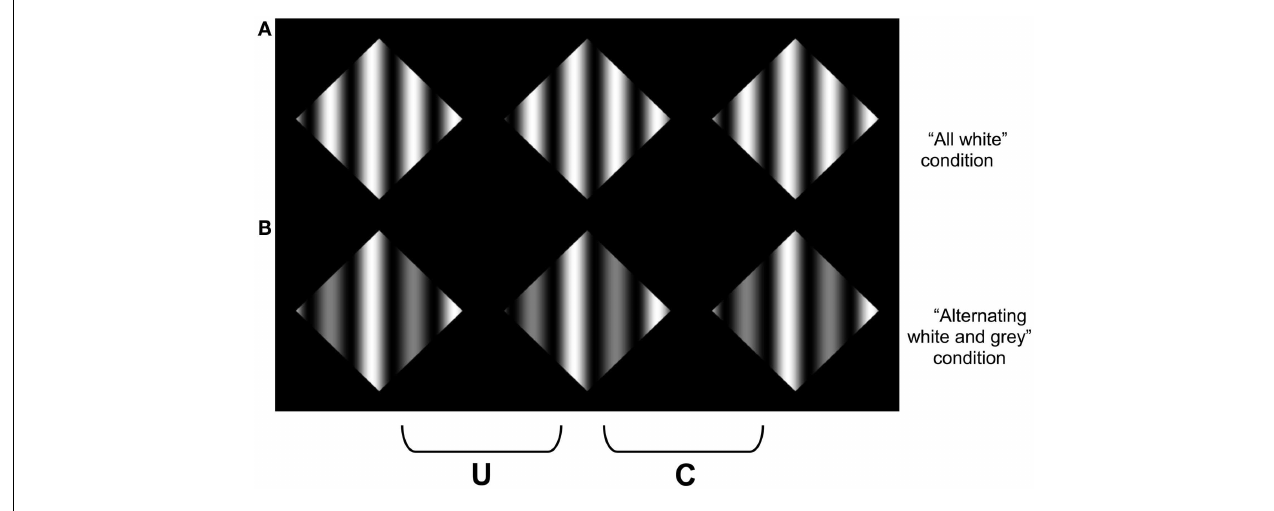
alternating cycles varied between black to white, and black to gray. Note that a coherent percept of scission may still be observed in (B) .